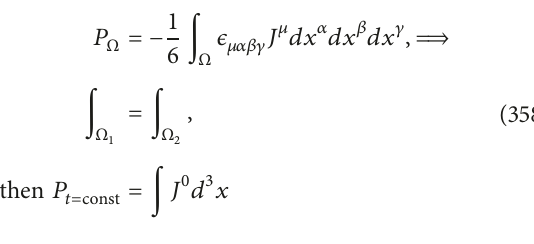
𝑖 0 ) . 0 휎 𝑖 Vector